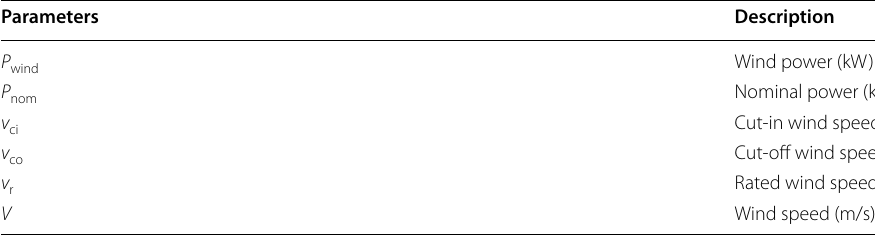
Table 3 Description of the parameters used in Eq. (2) Parameters